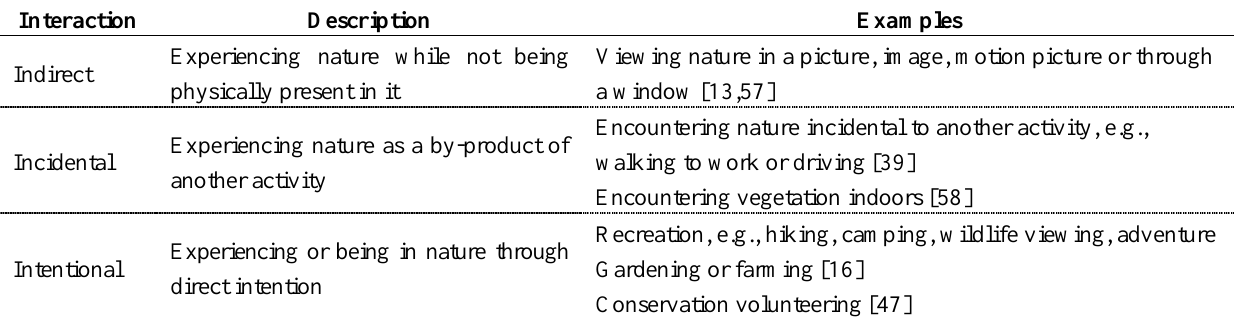
Table 2. Typology of interactions between people and nature.